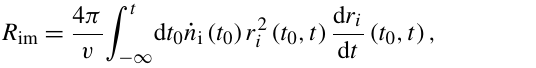
Table 1. Summary of assumptions for aerosols to be effective INPs in the model. Aerosol component Assumption to be effective INPs Fossil/bio-fuel OM–BC 0.05% of fSoot with fewer than one monolayer of sulfate and 0.1% with one to three monolayers of sulfate when RH i reaches 120%. Biomass OM–BC 0.1% of bSoot when RH i reaches 120%. Aircraft OM–BC Pre-activated aircraft soot within contrails with fewer than three monolayers of sulfate when RH i reaches 120%. Dust Dust with fewer than three monolayers of sulfate coating 120% when RH i reaches. SOA The newly formed SOA grows to the accumulation mode and meets the requirements of the glass transition temperature and RH i calculated using the equations in Wang et al. (2012) when RH i reaches